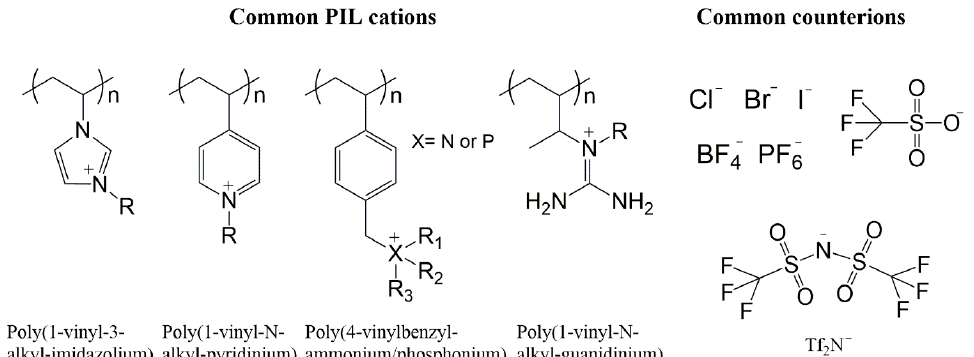
Figure 5. Chemical structures of common cations and counteranions used in PILs. Adapted from